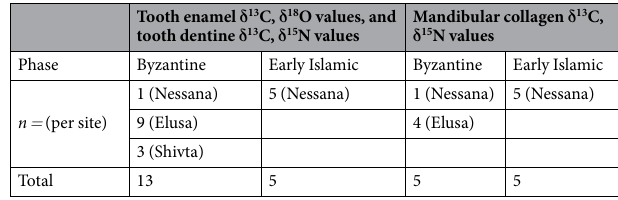
Table 1. Breakdown of samples analyzed in this